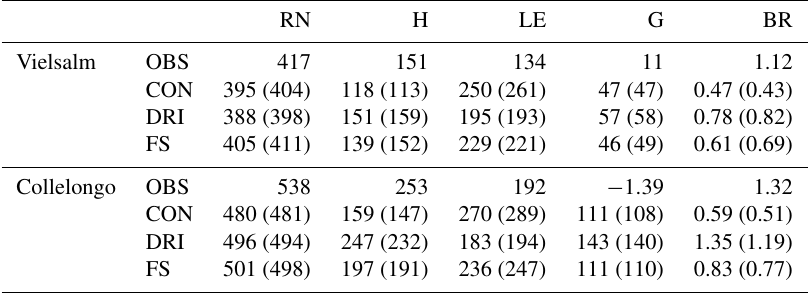
Table 4. The daily maximum surface energy fluxes (Wm − 2 ) averaged over the 5-year JJA period from 1996 to 2000 and the 10-year period from 1991 to 2000 (in